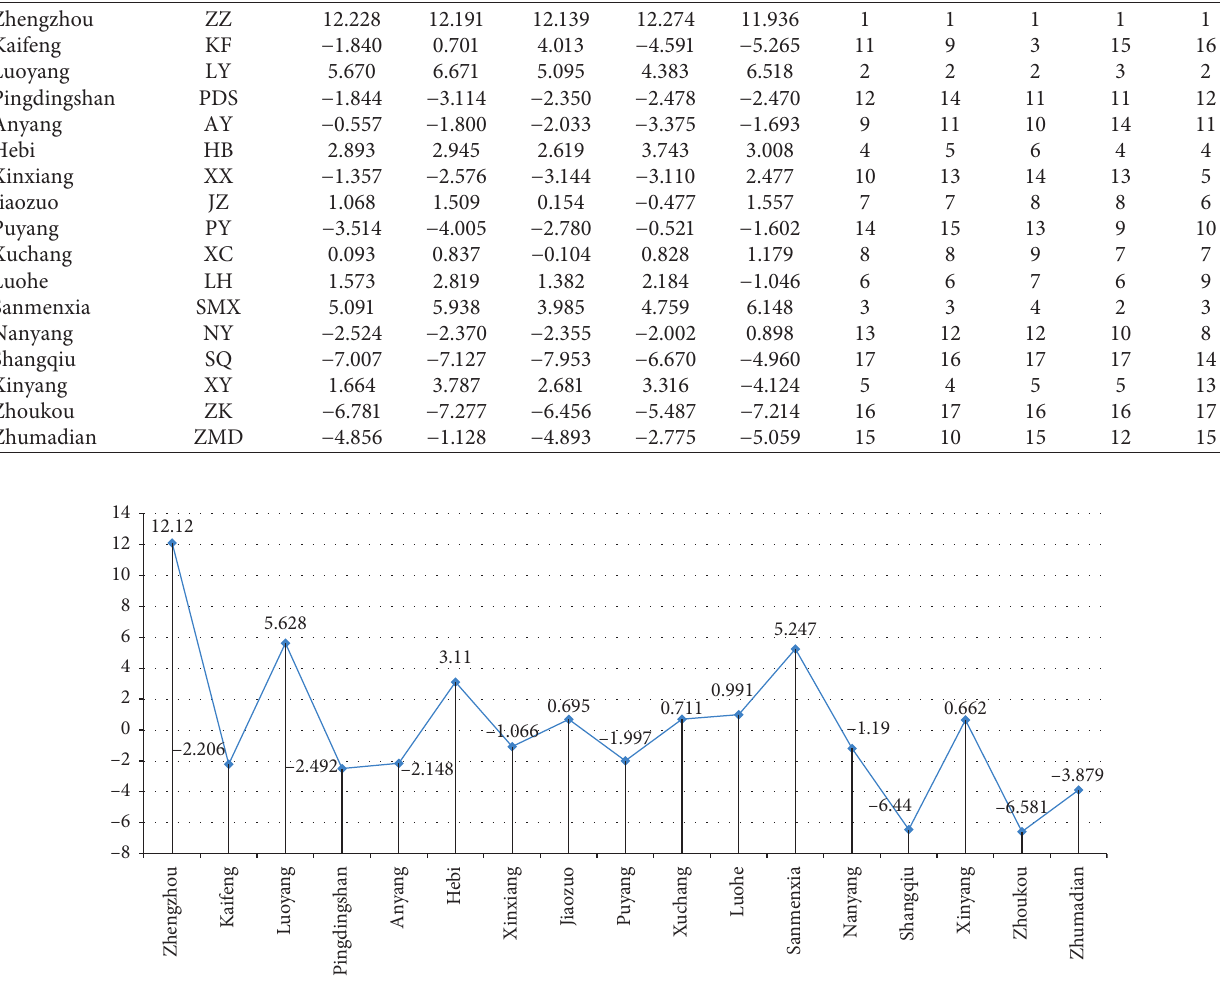
Table 3: The dynamic evaluation value and ranking of urban sustainable development in Henan Province from 2013 to 2017. City